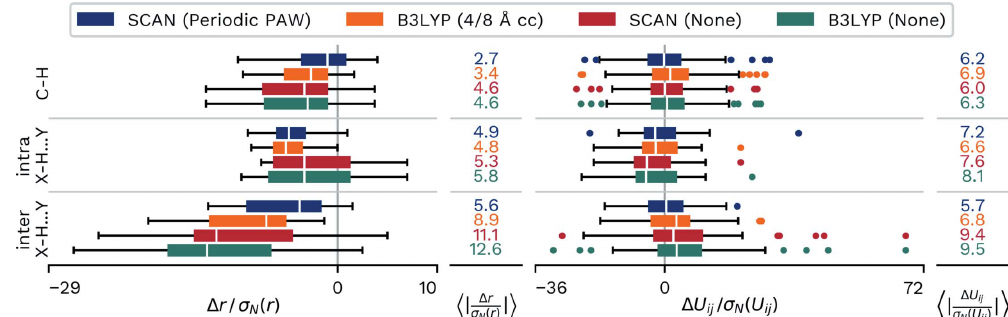
Figure 10 Differences in X —H bond distances and anisotropic displacement parameters divided by the estimated standard deviations from the neutron diffraction refinement. H atoms are grouped by bond type and position in the fragment in NoSperA2 . Distributions are depicted as box-whisker plots. Additionally, absolute values over estimated standard deviations are averaged over all investigated H atoms. SCAN (Periodic PAW) was conducted with our script and GPAW . B3LYP (4/8 A˚ cc) uses 4/8 A˚ of cluster charges and was refined with NoSpherA2 / TONTO . B3LYP/SCAN (None) were calculated with NoSpherA2 / ORCA without any approximation of the crystal